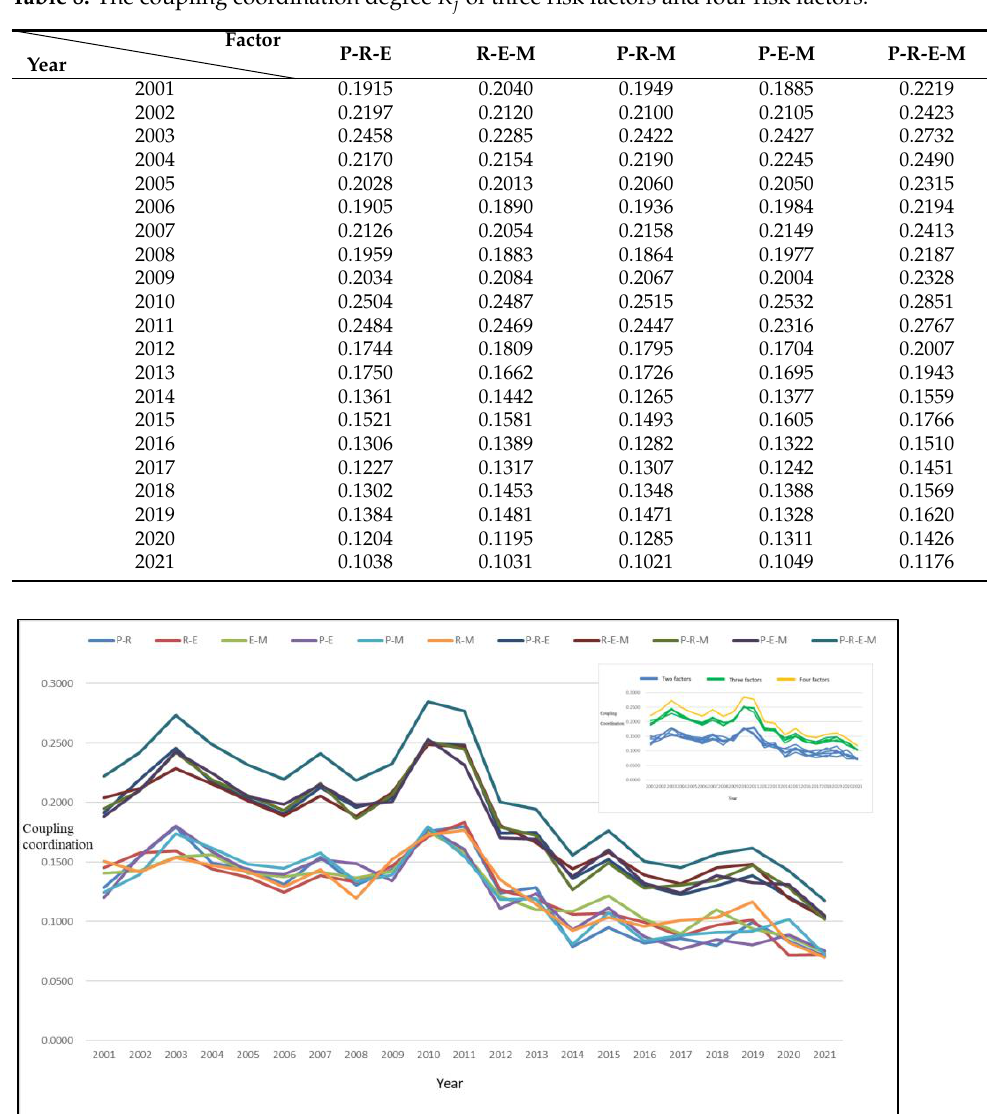
Figure 7. Visualization of coupling coordination degree calculation results .